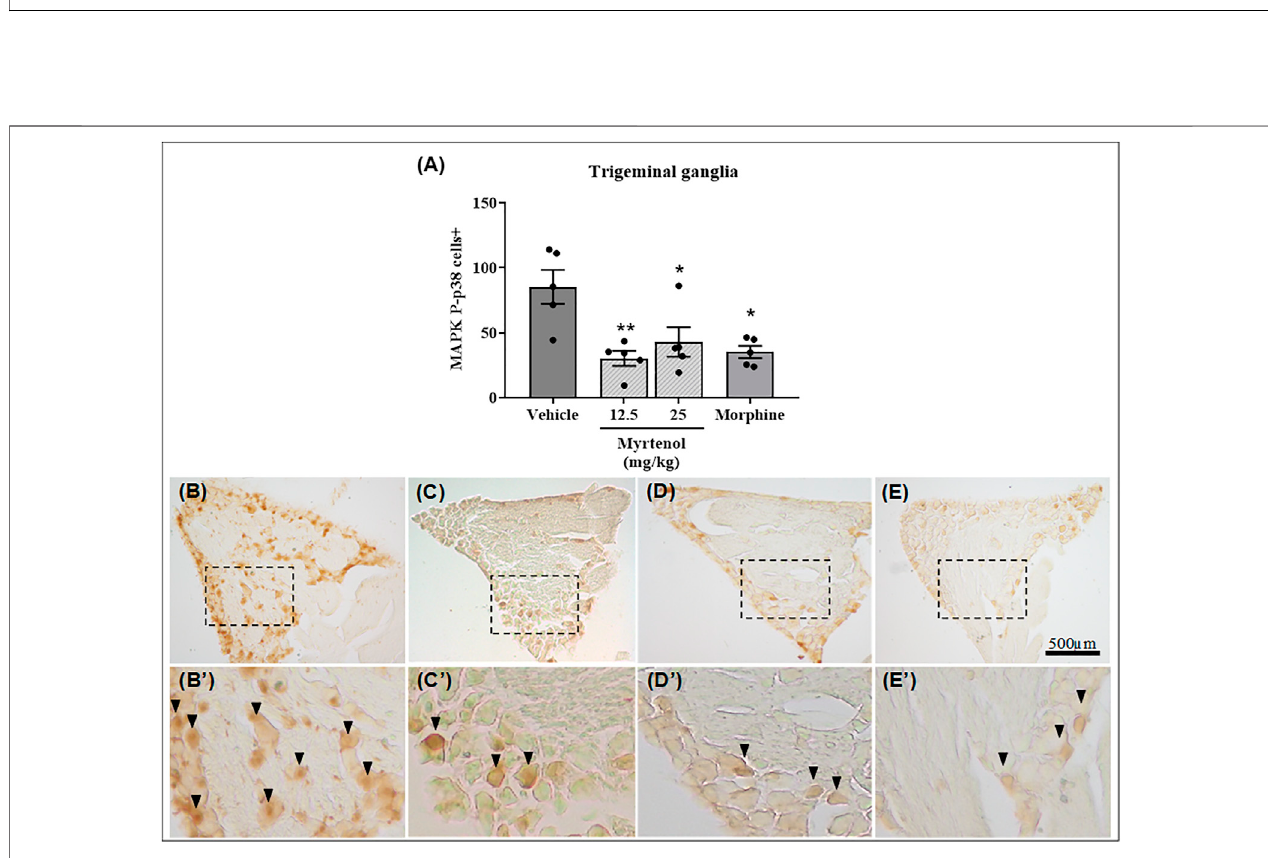
FIGURE 1 | Effectof myrtenolpretreatment on formalin-induced orofacial nociception. Nociceptive behavior wasmeasured as the face rubbing time in seconds (n = 5 – 6). (A) : fi rst phase of formalin test, (B) : second phase of formalin test. ANOVA [F (3,17) = 13.18, p = 0.001 and F (3,17) = 40.93, p < 0.001, respectively] followed by